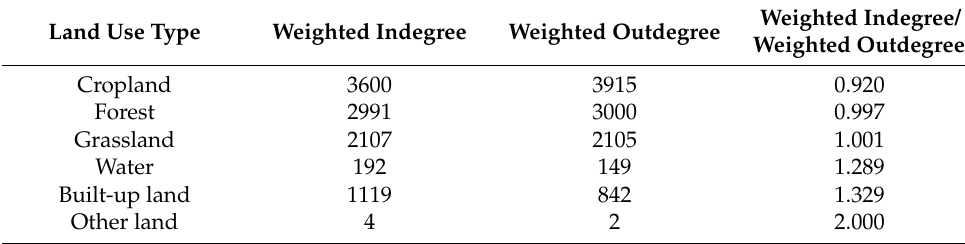
Table 7. Weighted indegree and weighted outdegree from 2000–2015.